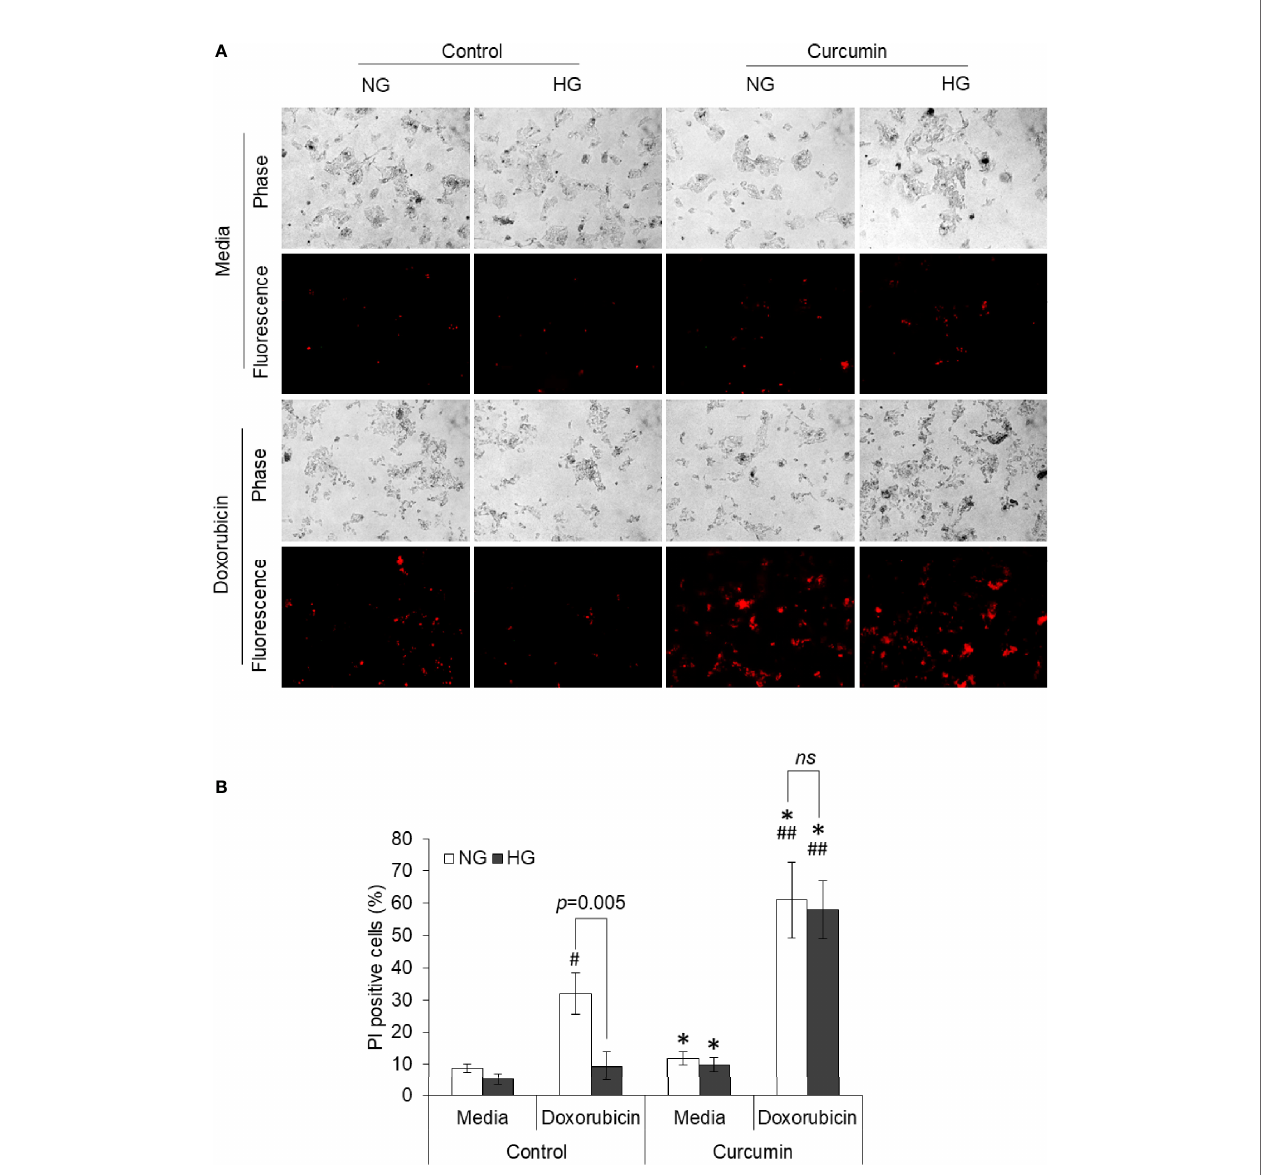
FIGURE 5 | Curcumin upraises the inhibited induction of cell death by doxorubicin in HG medium. HepG2 cells incubated in NG or HG medium with and without curcumin or doxorubicin (10 µM) for 24 h. PI staining was done, and cells were observed under fl uorescence microscopy to detect dead cell population (A) . Fluorescing dead cell percentage was enumerated (B) . Photomicrographs shown are representative of three experiments conducted independently. The values shown are Mean ± SD of three independent experiments conducted in triplicate. * p < 0.05 vs values of cells of control group not treated with curcumin. # p < 0.05, ## p < 0.01 vs values of cells not treated with doxorubicin. ns, not signi fi